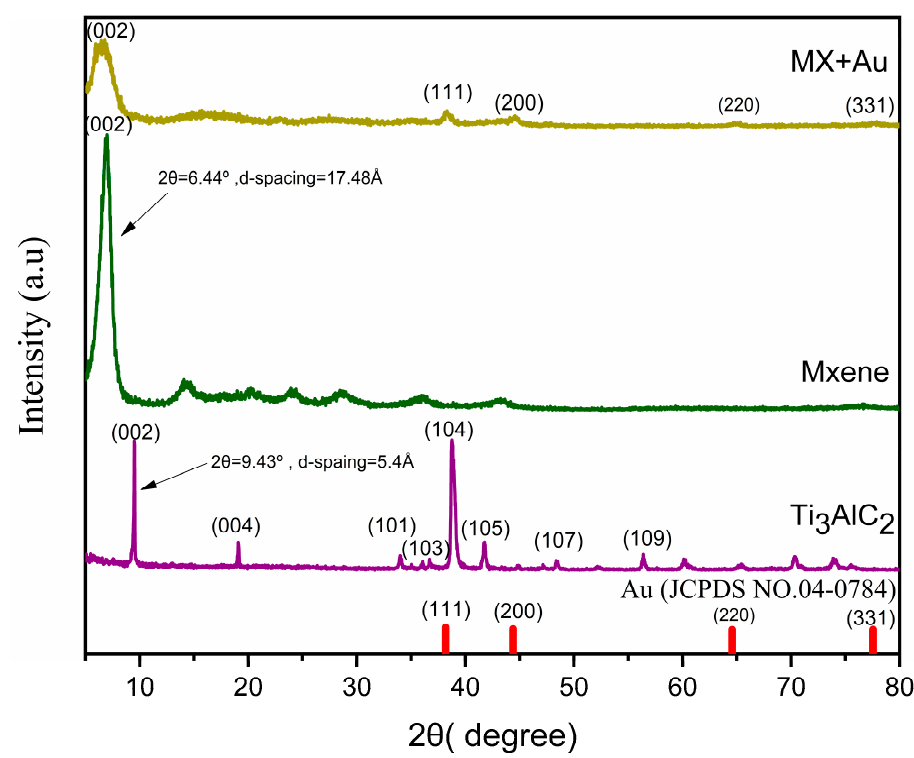
Figure 2. XRD patterns of Ti 3 AlC 2 , Ti 3 C 2 T X , AuNPs, and MXene/AuNPs.